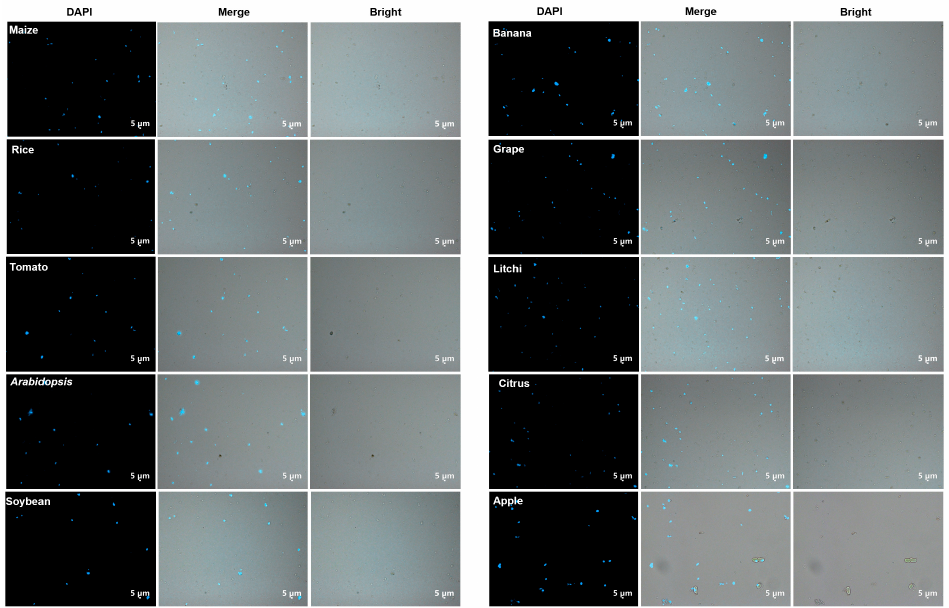
Figure 2. Isolated nuclei of the ten plants before purification observed using a ZEISS Axio Imager D2 microscope. Scale bars = 5 µm.